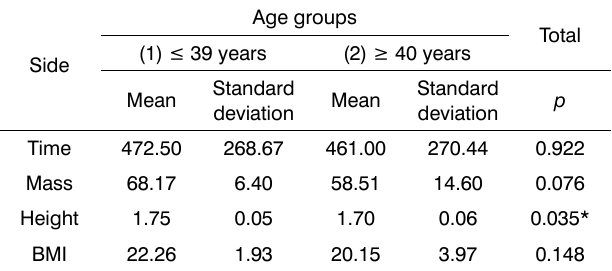
Table 3. Characterization of the sample in time elapsed after death, body mass, height, and the BMI. The t test for indepen- dent samples was applied to analyze the relationships between groups 1 and 2 according to the age group and the variables mentioned